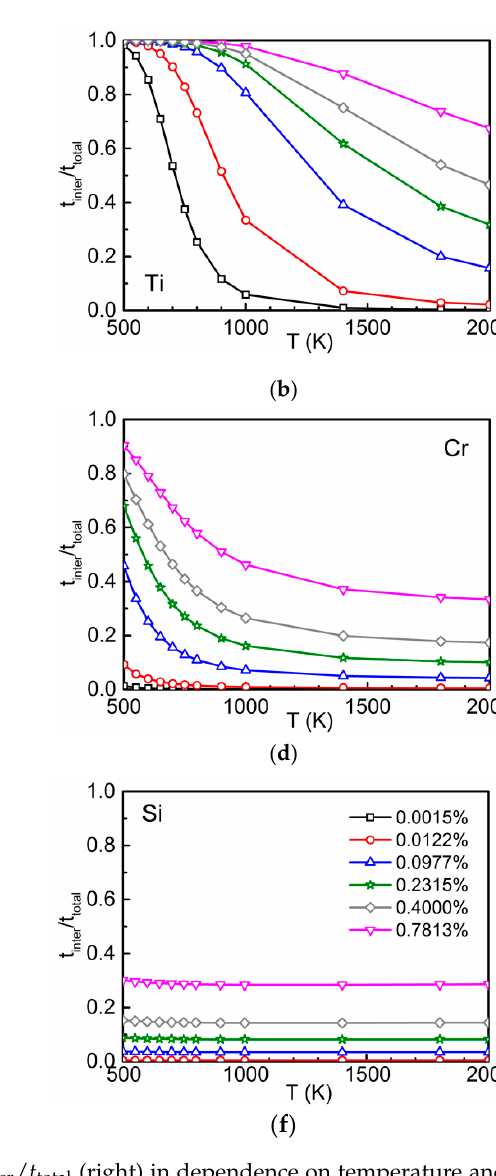
Figure 4. Relative deviation